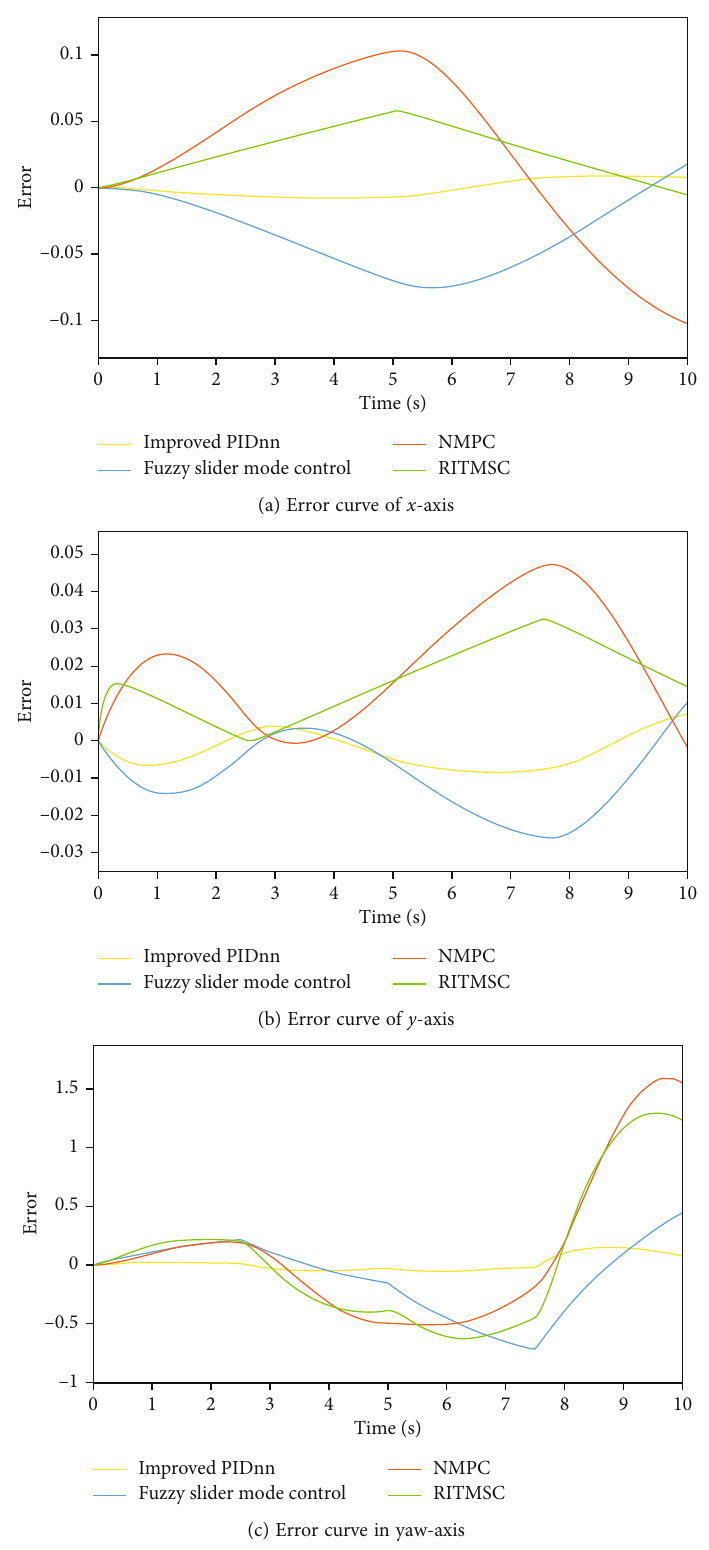
Figure 13: Motion trajectory comparison of advanced algorithms